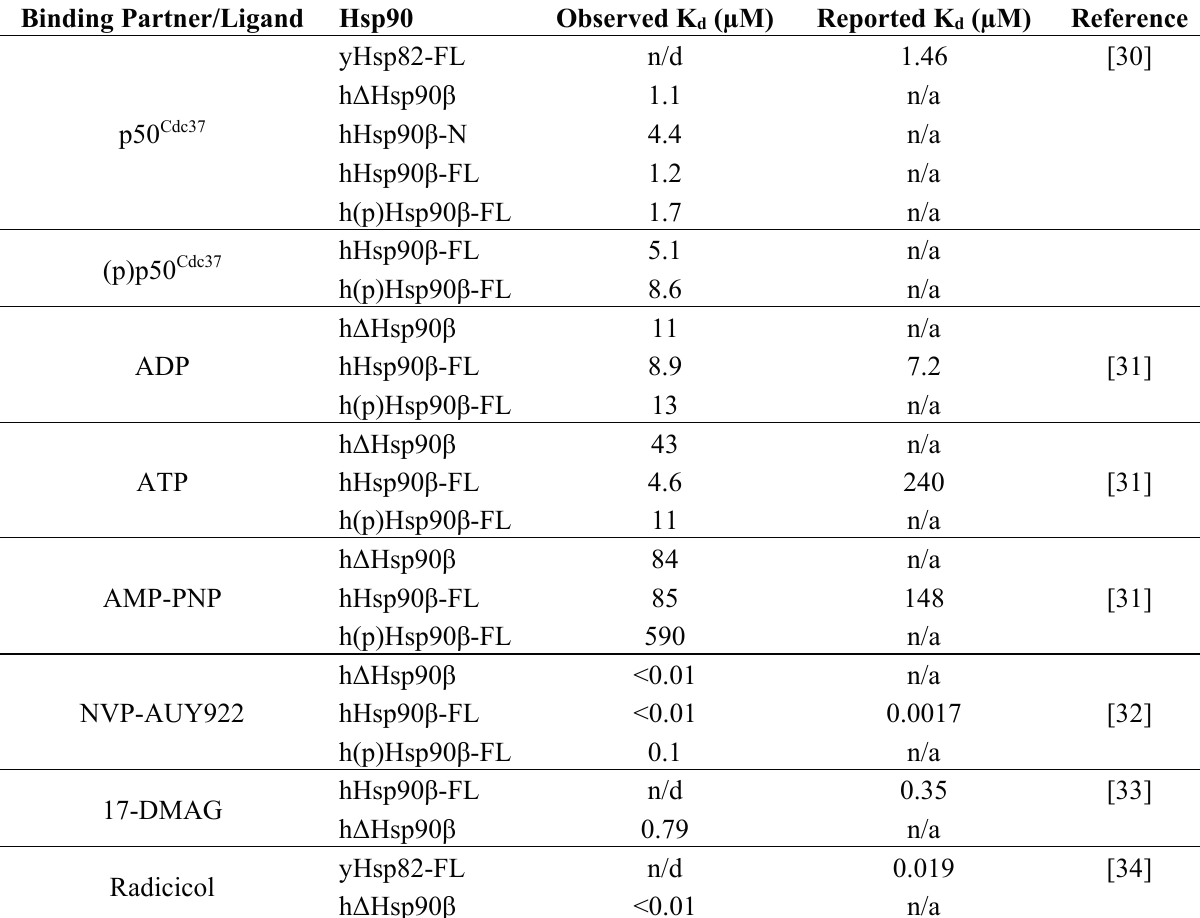
Table 1. Dissociation constants determined by ITC and comparison with reported